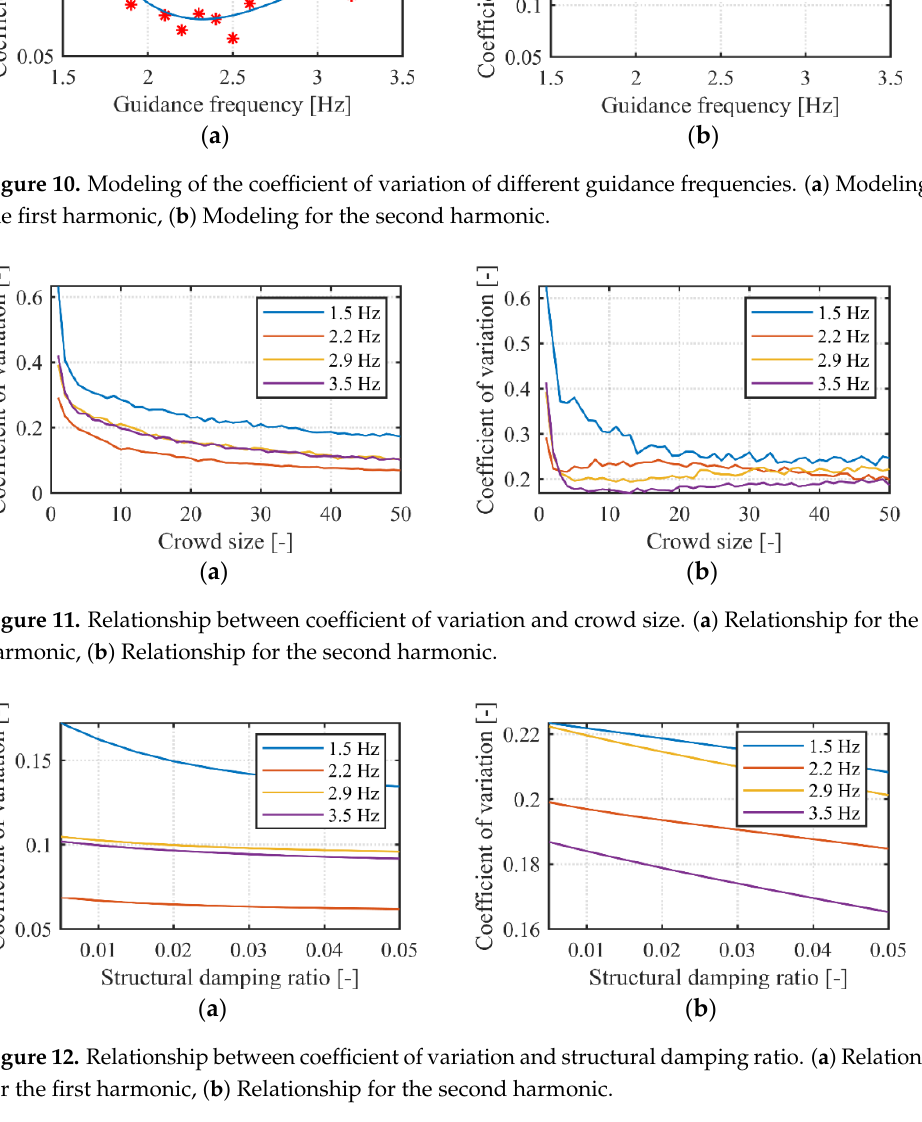
Figure 12. Relationship between coefficient of variation and structural damping ratio. ( a ) Relationship for the first harmonic, ( b ) Relationship for the second